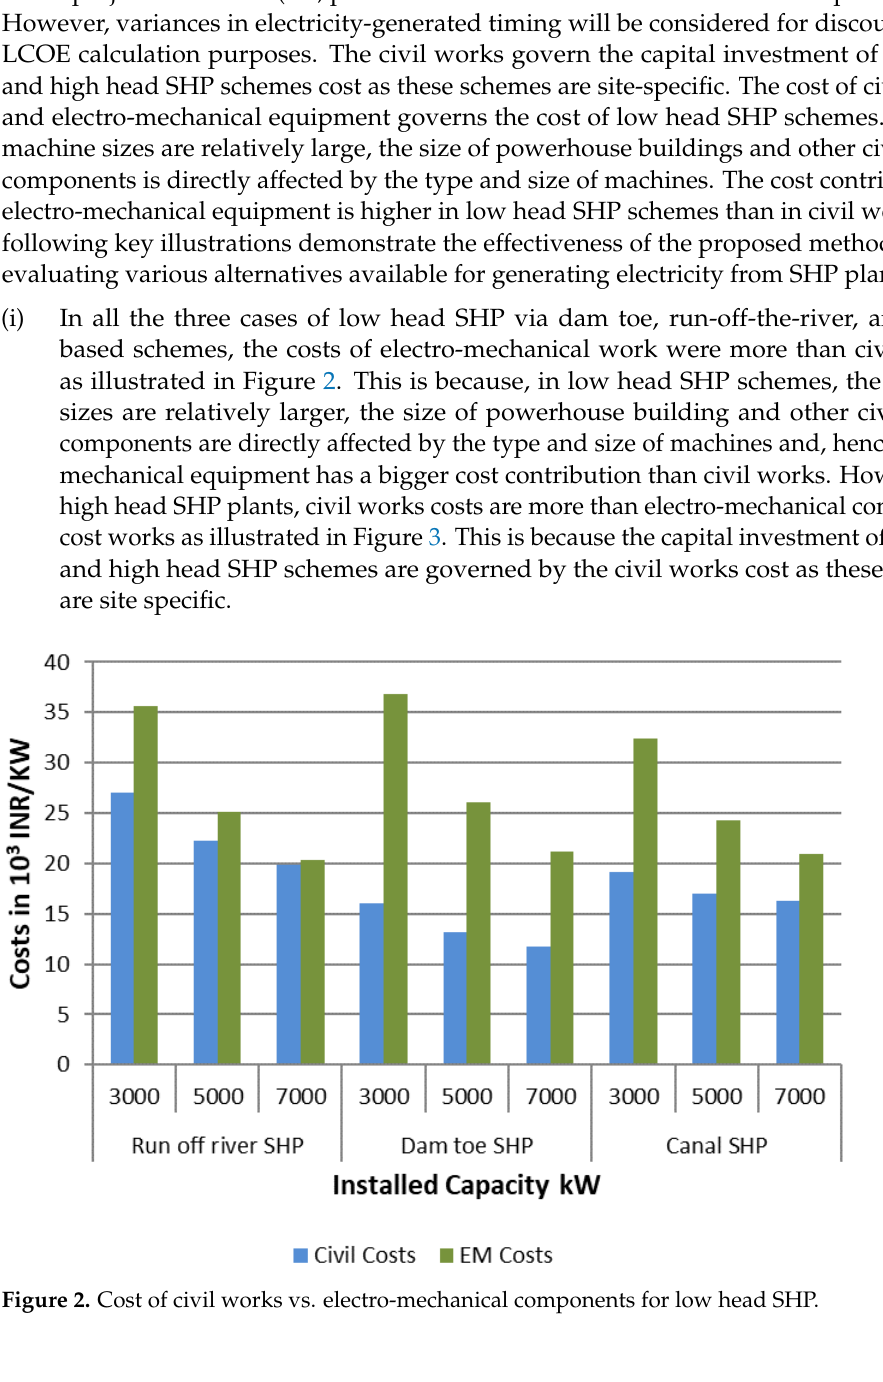
Figure 3. Cost of civil works vs. electro-mechanical components for 2000 kW plant.